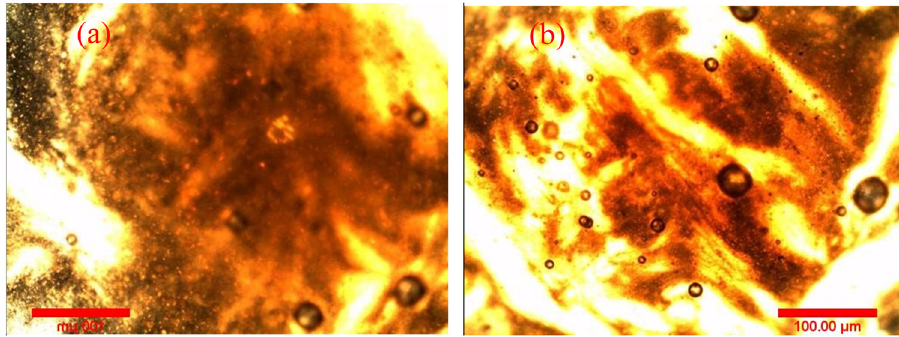
Figure 5: Photographs of orthogonal polarization of GO2/PAN/DMSO spinning dope with di ff erent concentrations. ( a ) 3%, ( b